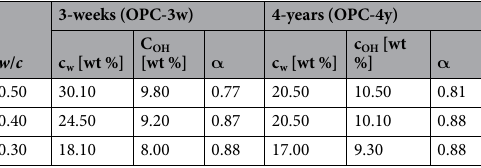
Table 1. Water (H 2 O) (c w ) and hydroxyl groups (c OH ) contents obtained from TGA for the 3 weeks (OPC-3w) and aged for 4-years (OPC-4y). The degree of hydration ( α ) is also